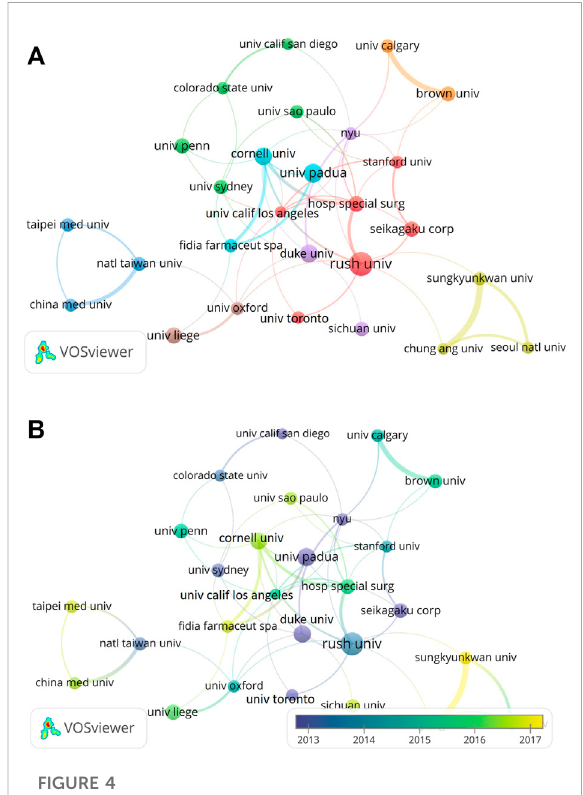
FIGURE 4 Visualization map of institutions involved in HA for the treatment of OA research. (A) Collaboration between institutions involved in HA for the treatment of OA research. (B) Dynamics and trends of institutions over